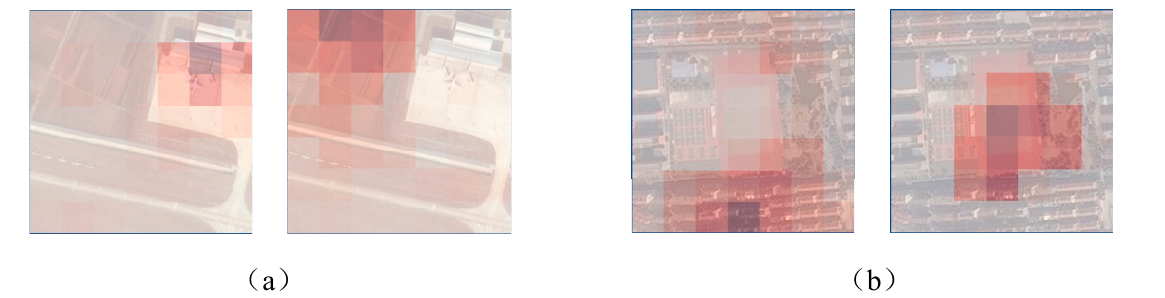
Figure 7. When the same “multi-scene semantics” RS image is retrieved by different statements, the weight distribution of each region of the image is significantly different. The change in color from white to red represents an increase in weight. This shows that CABIR can realize semantic recognition and shield image regions irrelevant to current retrieval. From left to right, the retrieval statements are: ( a ) “A plane is parked on the apron” and “There are large areas of brown farmland”; ( b ) “There is a large area of neat red buildings in the residential area” and “A playground with several basketball fields”.